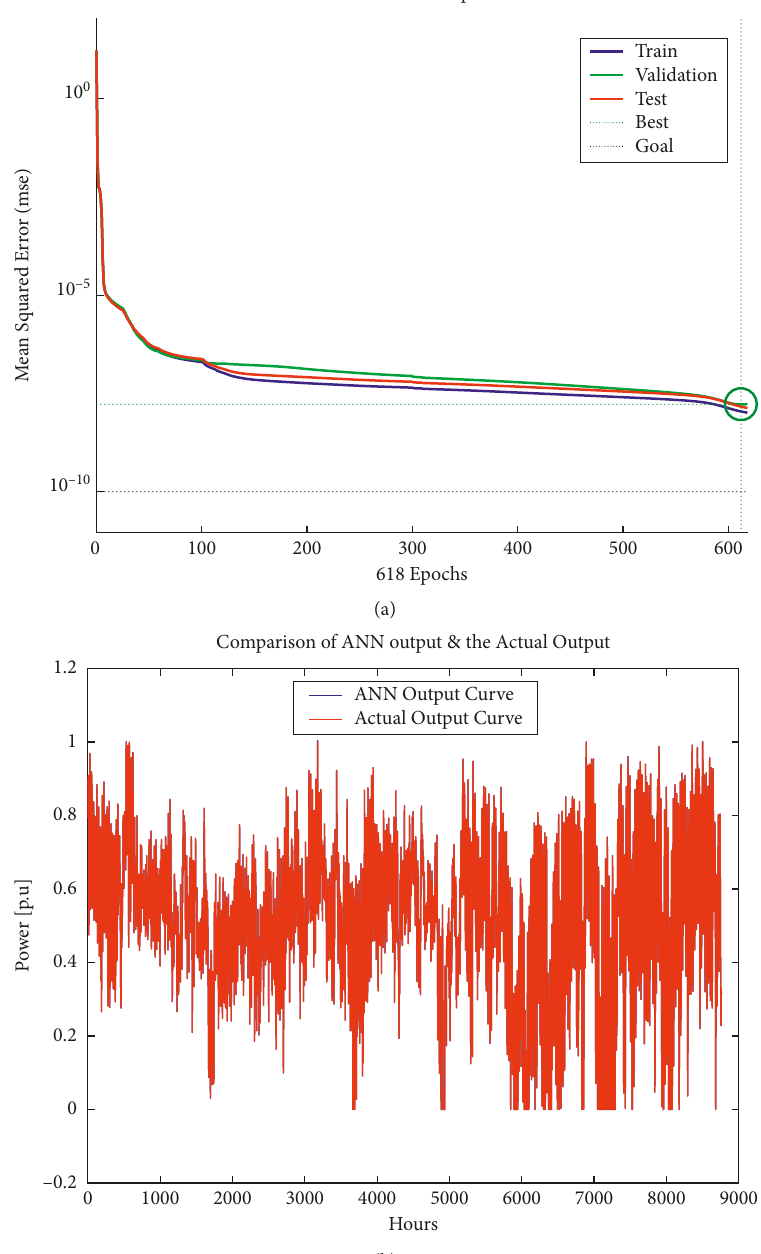
Figure 11: (a) Best validation performance plot for the BPNN. (b) Wind power forecasting